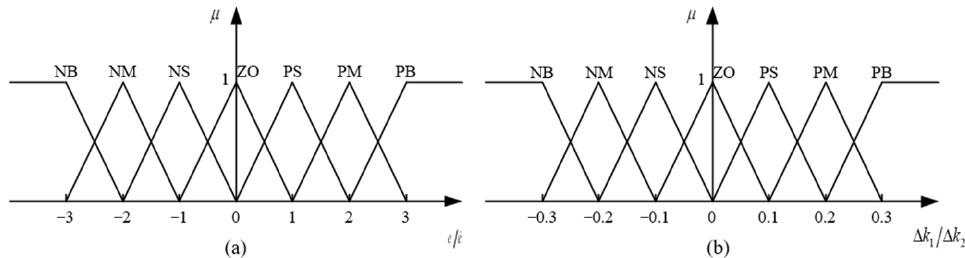
. e ; ( b ) membership function for